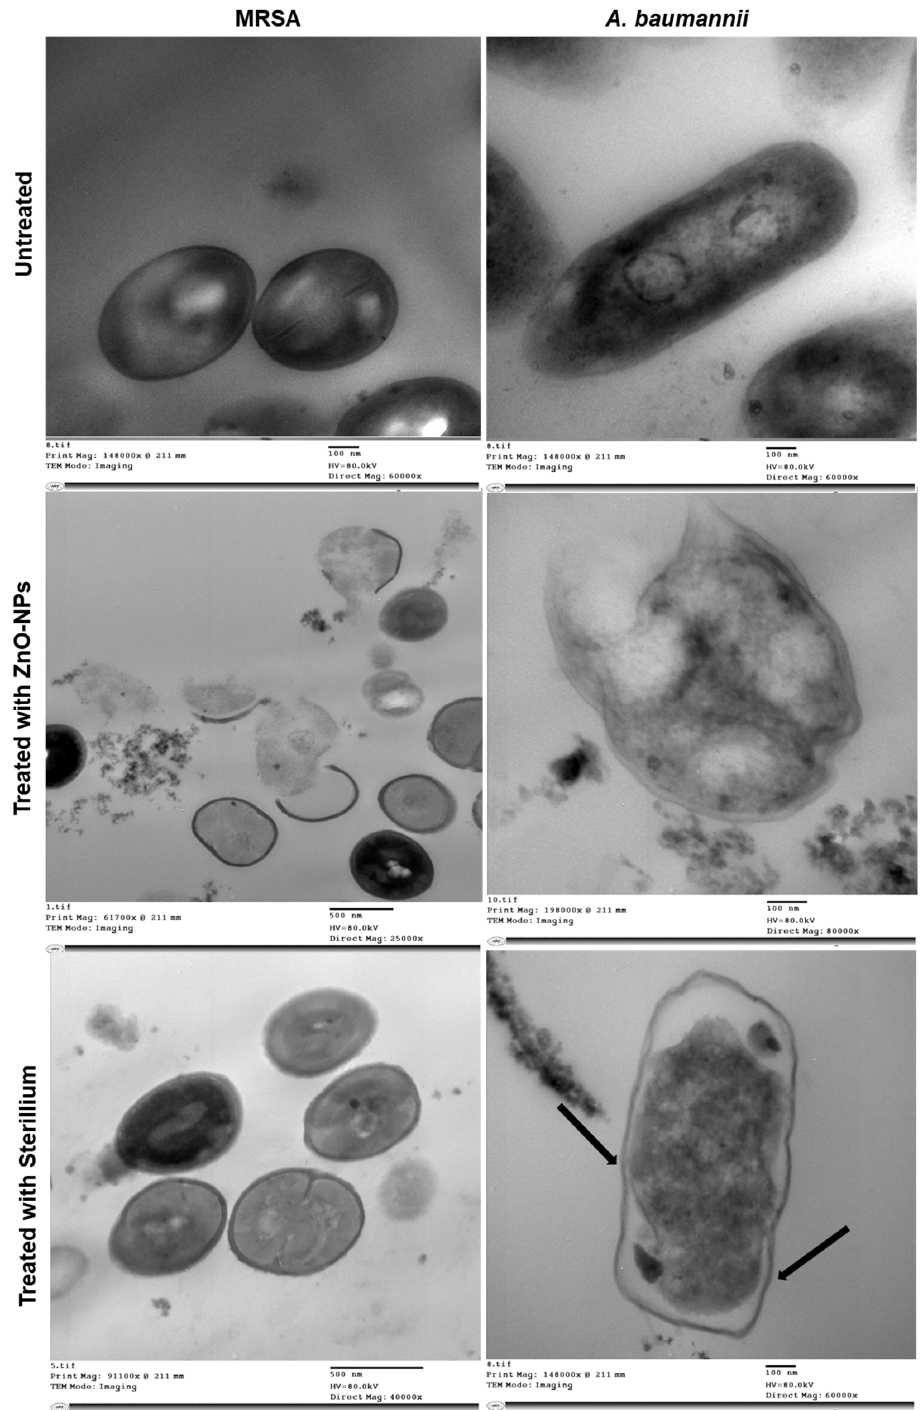
Figure 6. TEM images presenting the structural changes in MRSA and A. baumannii when treated with ZnO-NPs and Sterillium at a concentration less than MIC in comparison to untreated bacteria. As revealed, untreated bacteria showed a normal cell wall outline with no itching or degradation with the appearance of normal cytoplasm and intracellular components. However, bacterial damage was recorded in both bacteria treated with ZnO-NPs, and this involved damage to cell wall and release of intracellular contents, leading to bacterial death. In contrast, no structural changes were observed in MRSA after Sterillium treatment and this confirmed the lack of efficacy of Sterillium against MRSA; however, only morphological changes were observed with A. baumannii, such as appearance of body projection, as indicated by black